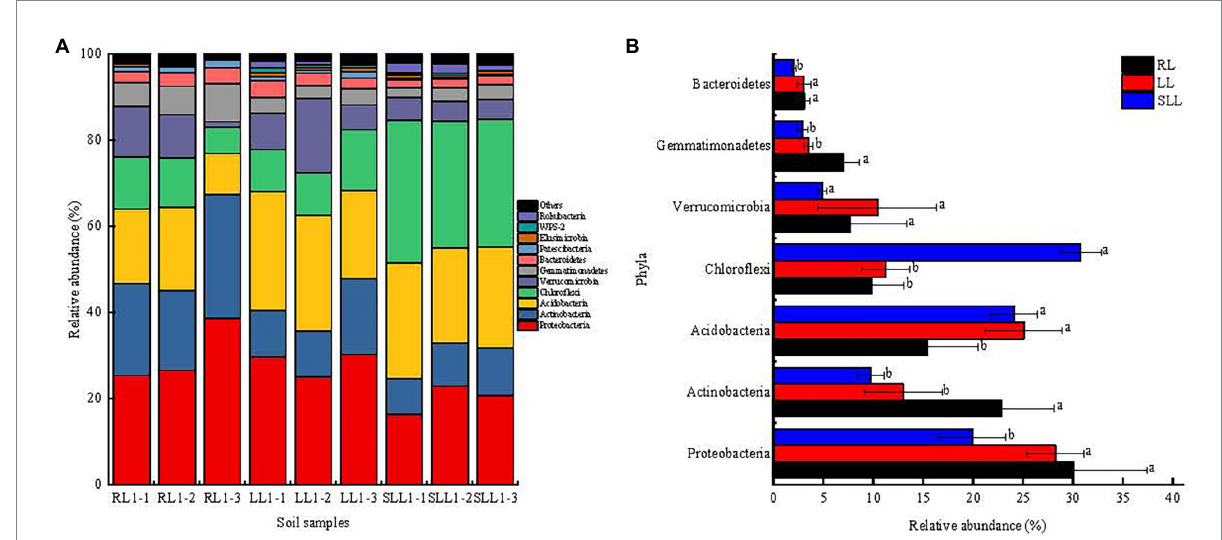
FIGURE 4 The relative abundance of soil bacterial taxonomic groups at phyla levels (A) and differences in the relative abundances of major bacterial community at the phyla (B) . Values are the mean ± SD. Different lowercase letters indicate statistically significant differences among different types